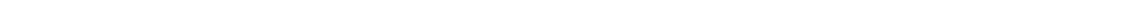
Fig. 7 Neuronal Vps34 de fi ciency in vivo leads to endolysosomal dysfunction and increased exosomal APP-CTF sorting. a Brain sections from 2-month-old Pik3c3 fl ox/ fl ox (CTRL) and Pik3c3 fl ox/ fl ox ; CaMKII - Cre ( Pik3c3 cKO) mice immunostained for MAP2 and p62. Scale bar, 500 µ m. b , c Western blot analysis of hippocampus lysates from 2-month-old CTRL and Pik3c3 cKO mice (mean ± SEM, N = 7 and 8, respectively in b ; N = 8 in c , from two independent experiments). c Right panel, soluble A β 40 and A β 42 levels in hippocampus lysates of 2-month-old CTRL and Pik3c3 cKO mice (mean ± SEM, N = 9 mice, from two independent experiments). * p < 0.05, ** p < 0.01, *** p < 0.001 in two-tailed Student ’ s t test. d LC – MS analysis of lipids extracted from hippocampus lysates of 2-month-old CTRL and Pik3c3 cKO mice. Values are expressed as average Mol% of total lipids measured, normalized to CTRL. (mean ± SEM, N = 8 and 9, respectively, from two independent experiments). * p < 0.05, *** p < 0.001 in two-tailed Student ’ s t test. e Western blot analysis of EVs isolated from the forebrain of 2-month-old CTRL and Pik3c3 cKO mice. Bar graph denotes average protein levels normalized to CTRL (mean ± SEM, N = 4 mice, from two independent experiments). * p < 0.05 in two-tailed Student ’ s t test. f LC – MS analysis of EVs from 2-month-old CTRL and Pik3c3 cKO mice. Values are express ed as average Mol% of total lipids measured, normalized to CTRL. For complete lipid panel and BMP species analysis, see Supplementary Fig. 8e. (mean ± SEM, N = 6 mice, from two independent experiments). * p < 0.05, ** p < 0.01 in two-tailed Student ’ s t